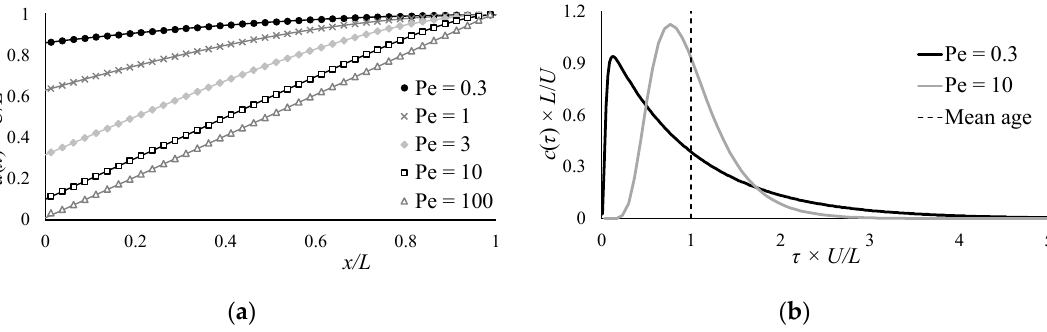
Figure 3. ( a ) Computed (symbols) and analytical (solid lines) profiles of water mean age a ( x ) in a one-dimensional prismatic channel, and ( b ) corresponding age distribution functions.